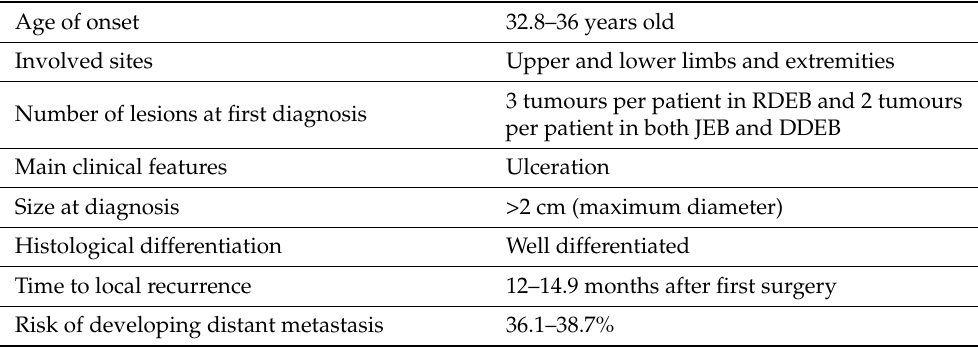
Table 1. Main features of cSCC in EB